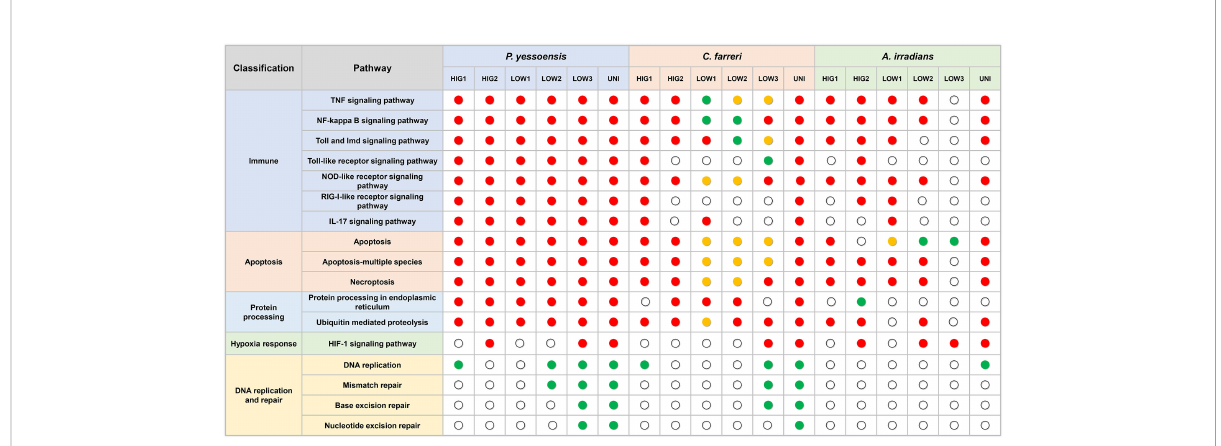
FIGURE 8 Key pathways in the three scallop species in response to different kinds of environmental stresses. Red dot represent enriched pathways in upregulated DEGs, green dots represent enriched pathways in downregulated DEGs, and yellow dots represent enriched pathways in both up- and downregulated